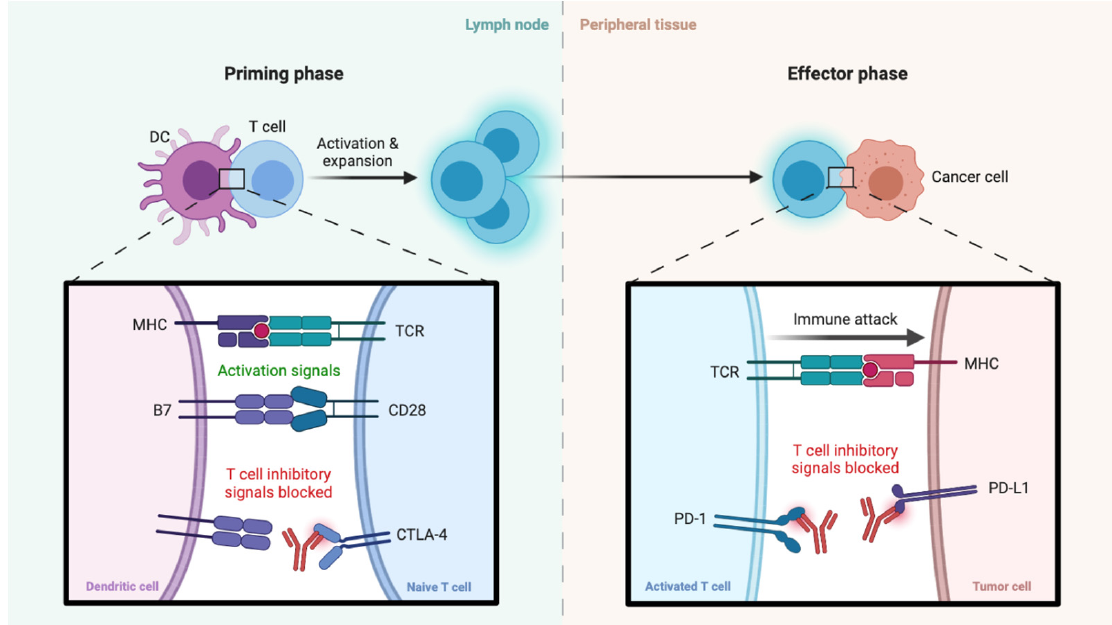
Figure 2. Schematic figure reporting some mechanisms of action of immune checkpoint inhibitors (ICIs) in cancer immunotherapy. On the left side of the figure, the immune checkpoint inhibits T-cell activation, while PD-1 inhibitors enhance the immune system response against cancer cells through T cell activation (on the right ). Abbreviations: CTLA-4: Cytotoxic T Lymphocyte antigen 4; MHC: Major Histocompatibility Complex; PD-1: programmed cell death protein 1; PD-L1: programmed death-ligand 1.